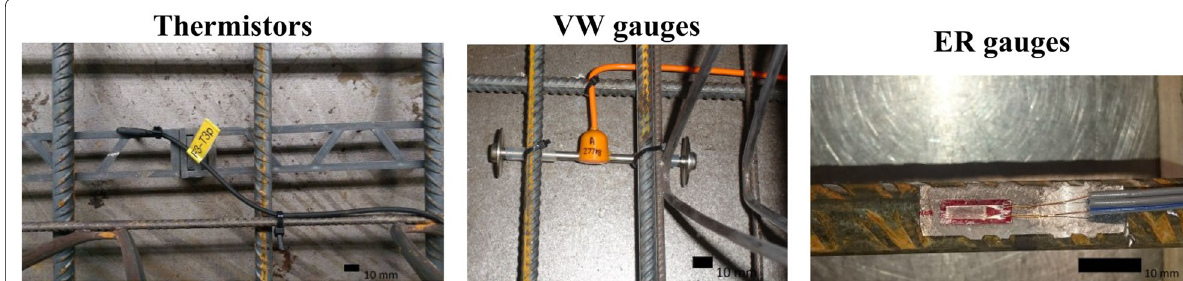
Fig. 4 Sensors embedded in the buildings’ structure (Newell and Goggins 2017).